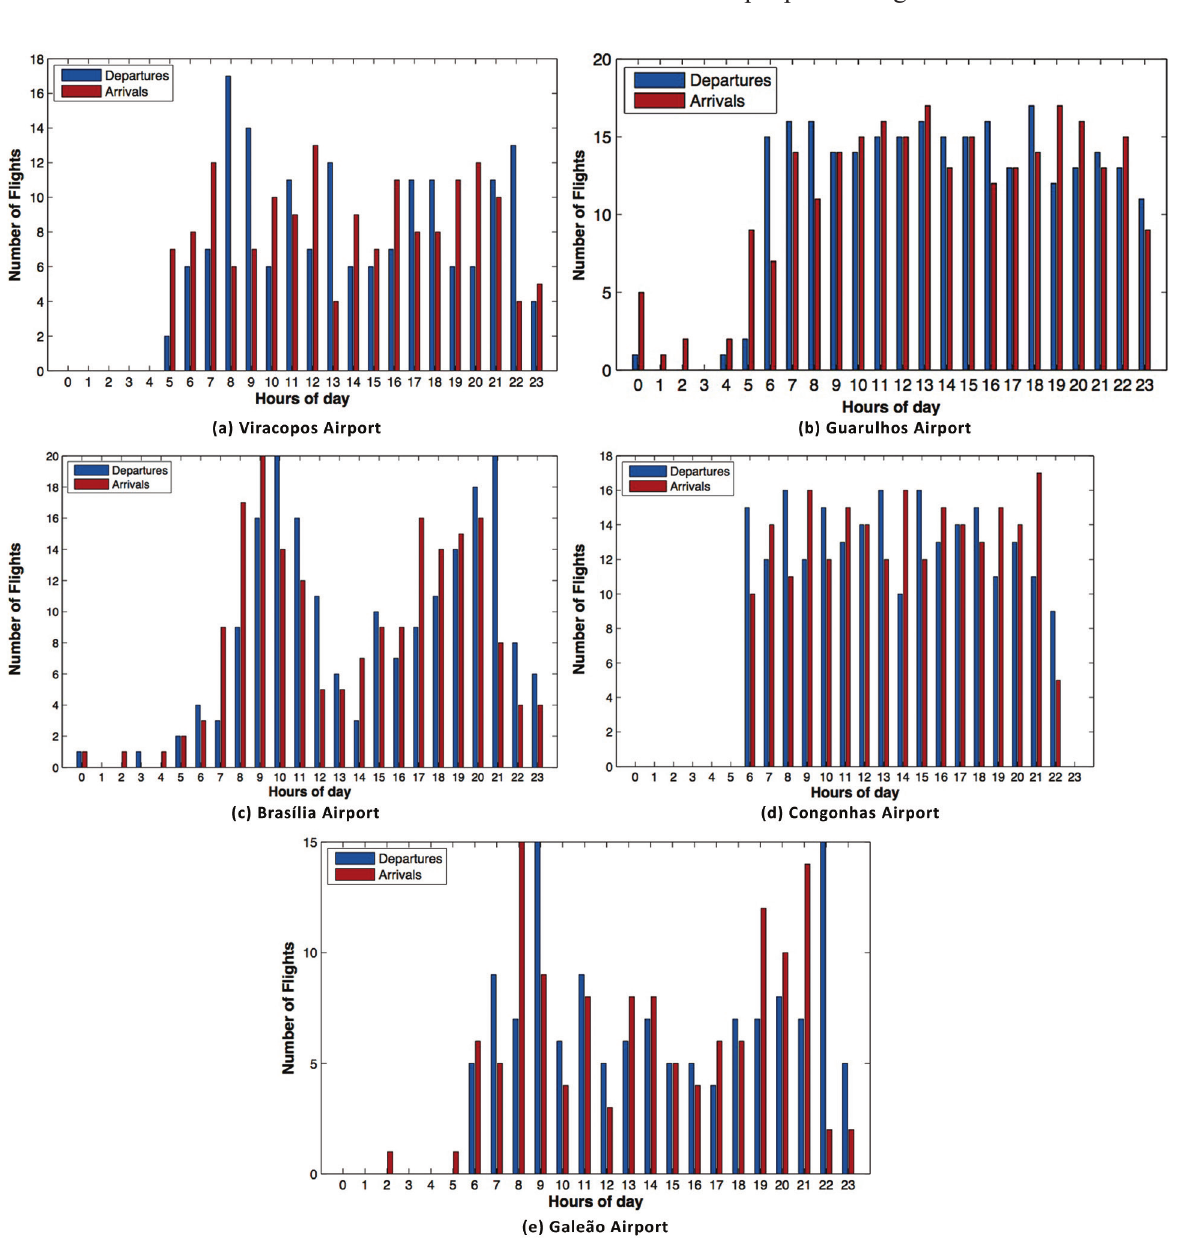
Figure 6 - Daily distribution of flights. For interpretation of the references to color in this figure, the reader is referred to the web version of this